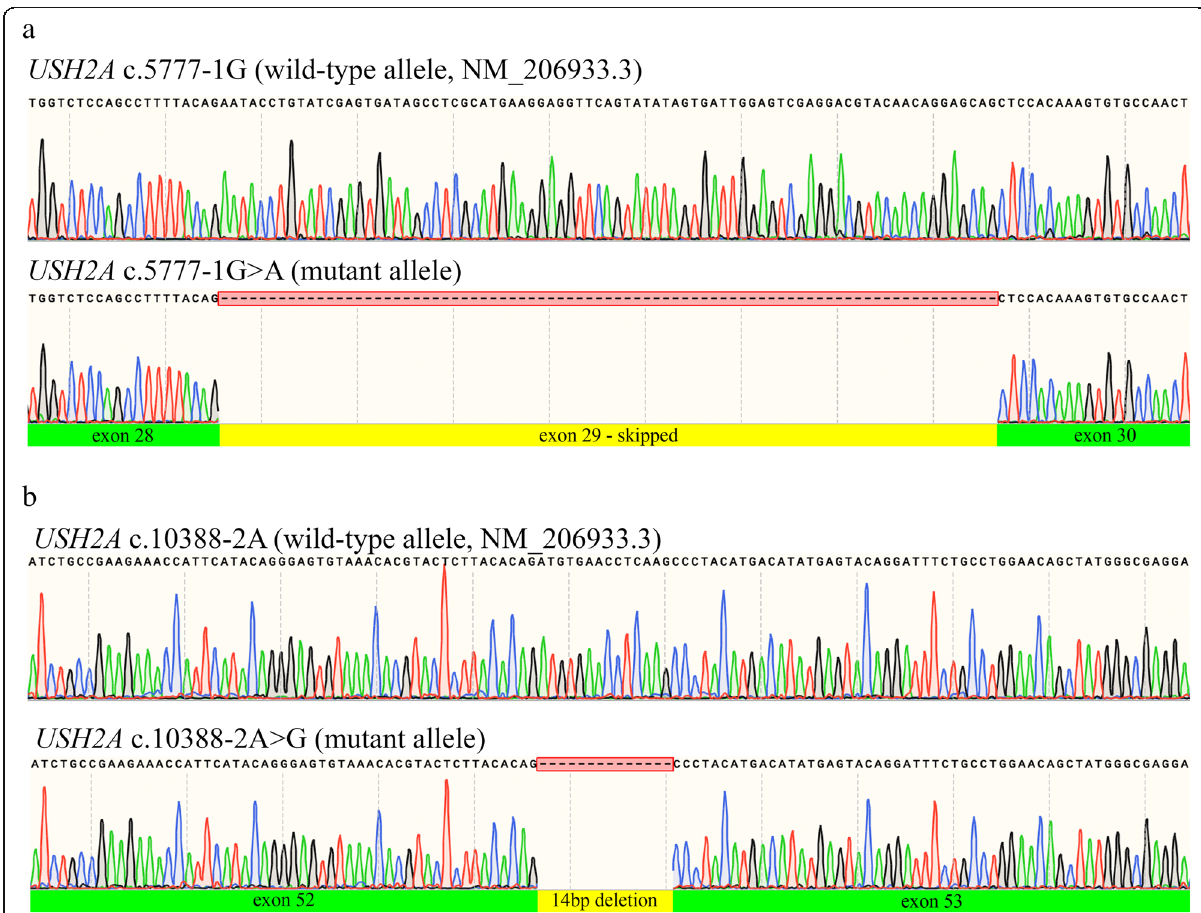
Fig. 3 Sequence electropherograms of USH2A c. 5777-1G > A and 10,388-2A > G RT-PCR products. a) USH2A c. 5777-1G> A causes exon skipping and the in-frame deletion of 81 bp, b) USH2A 10,388-2A > G activates a cryptic acceptor splice site, resulting in the loss of 14 bp and a frameshift (p.